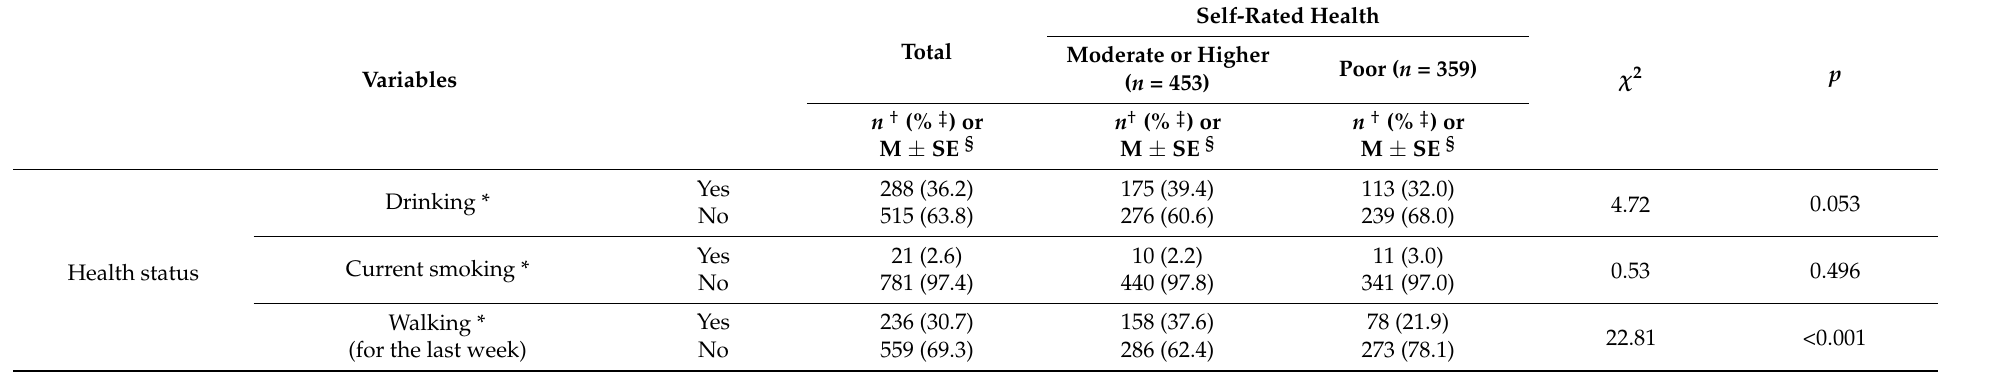
Table 2. Differences in self-rated health by health